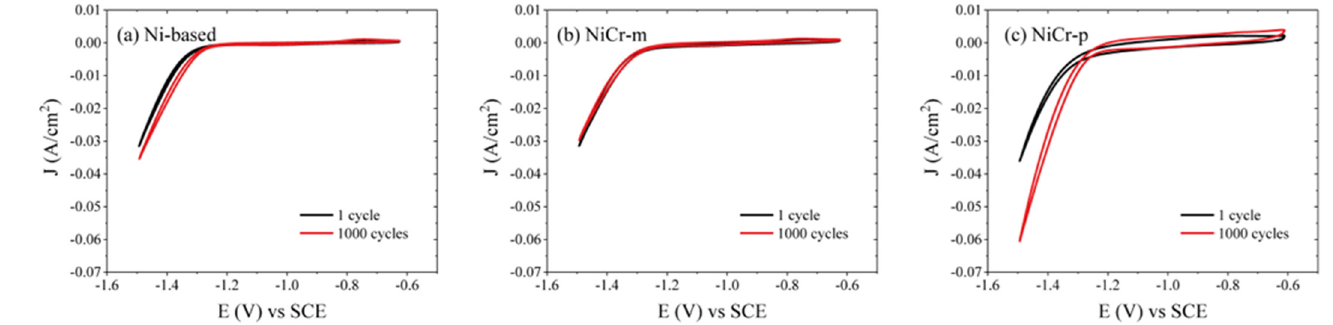
Figure 7. Cyclic voltammograms in 1.5 M NaOH at a scan rate of 100 mV s − 1 from − 1.5 to − 0.6 V for